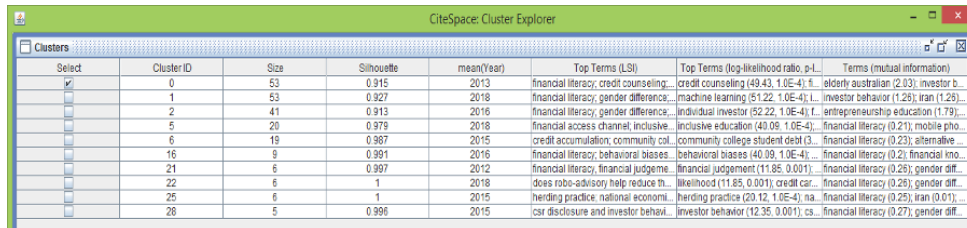
Figure 6. A summary table of cluster explorer extracted from the abstracts of the articles prepared using CiteSpace